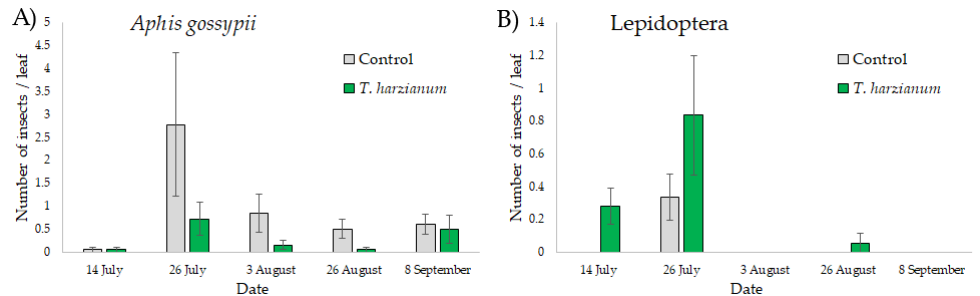
Figure 3. Mean values (±standard errors) of the number of apterous Aphis gossypii ( A ) and eggs of Lepidoptera ( B ) on zucchini leaves sampled from plants inoculated with T. harzianum T22 and control ones during the five sampling dates.